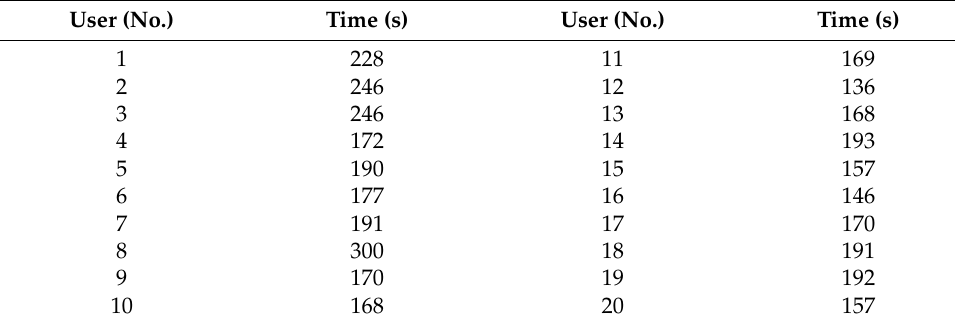
Table 2. The fitness time photographed by each